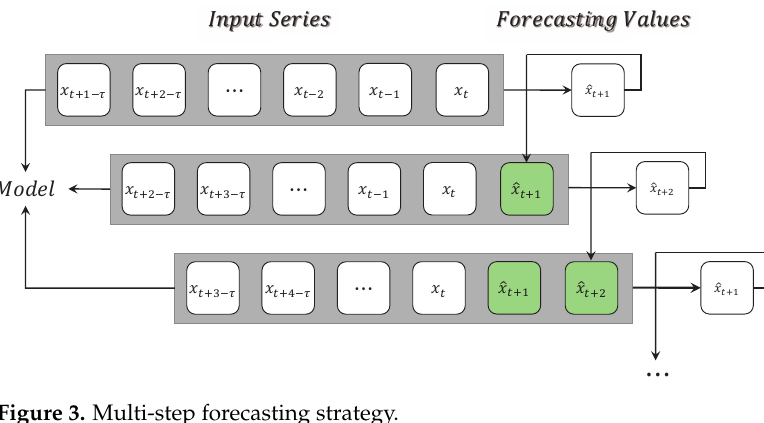
Figure 3. Multi-step forecasting